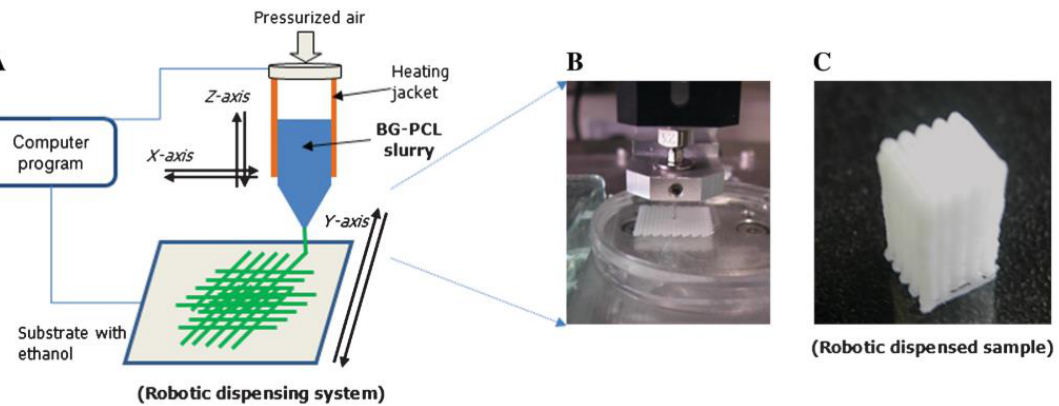
nozzle and deposited fiber mesh, and ( C ) three-dimensional PCL/BG composite scaffold. Reproduced from